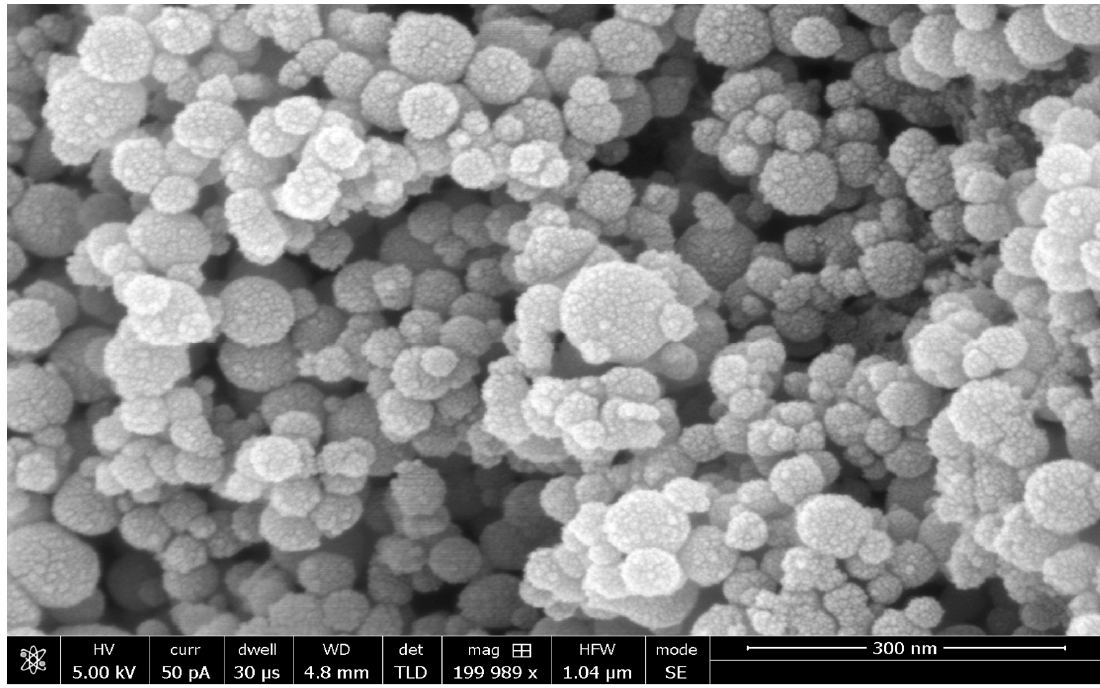
Figure 6. SEM micrograph of HA nanoparticles demonstrating their spherical shape and nano-size (<100 nm). Reprinted with permission from Al-Hamdan et al. [33]. Copyright 2020